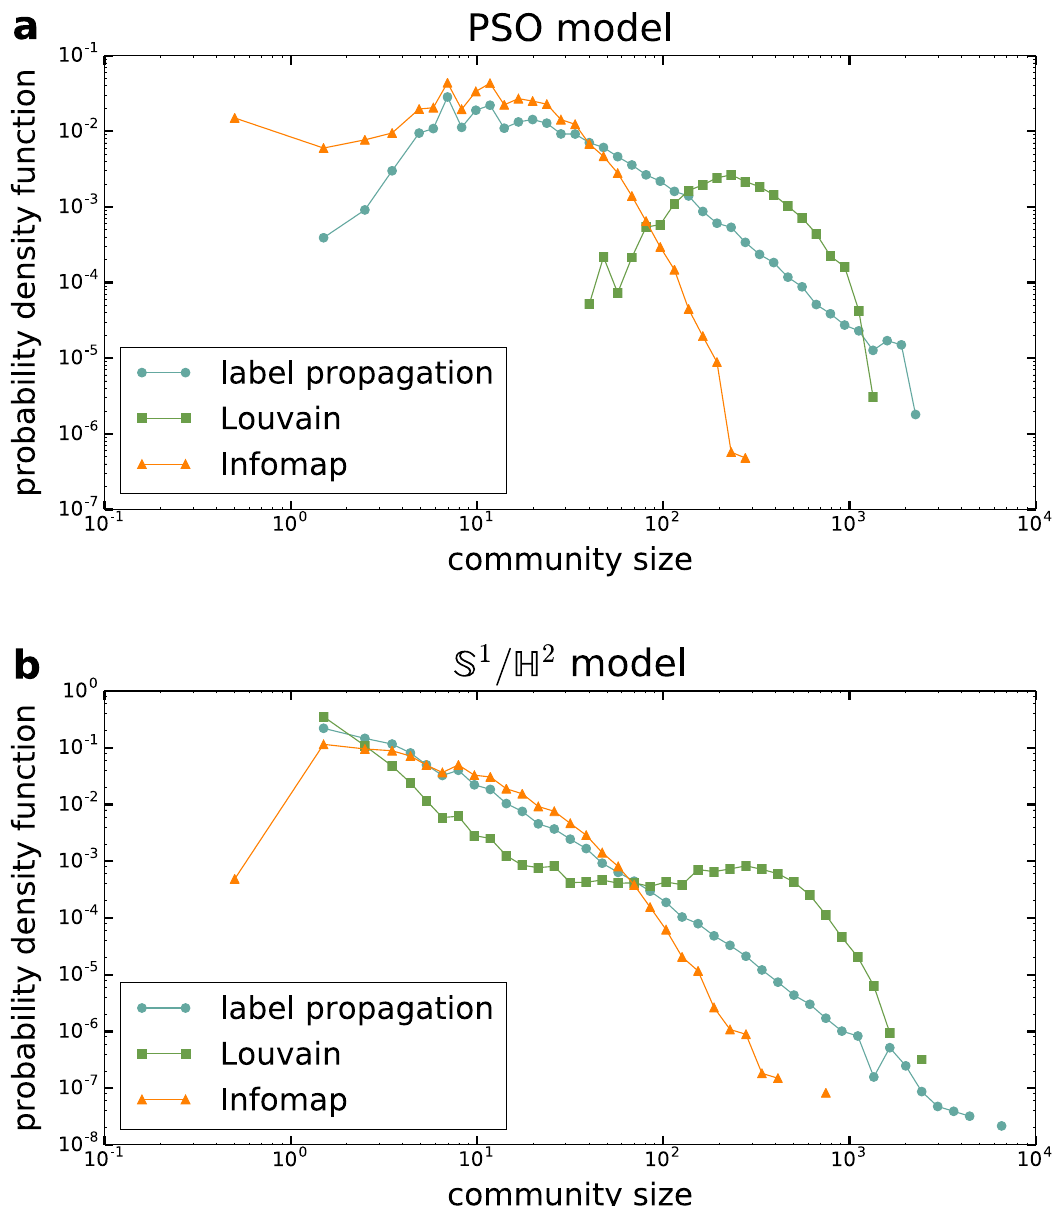
Figure 7. Community size distributions. ( a ) The probability density function of the community size in the PSO model according to asynchronous label propagation (blue circles), Louvain (green squares) and Infomap 10,000 , expected average degree (orange triangles) based on 100 networks of size N = T 0.2 and popularity fading parameter β 0.7 . ( b ) The probability density function of the community size in = = the S 1 / H 2 model with the same symbol and colour coding as in ( a ), based on 100 networks of size N k 0.2 and 1 /(γ 1 ) 0.7 10 , 1 /α expected average degree = − = � � =